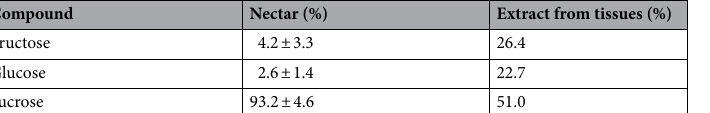
Table 1. The relative composition (% weight) of the carbohydrate fraction of nectar ( n = 4, mean ± SD) and sugars extracted from the whole floral tissues.